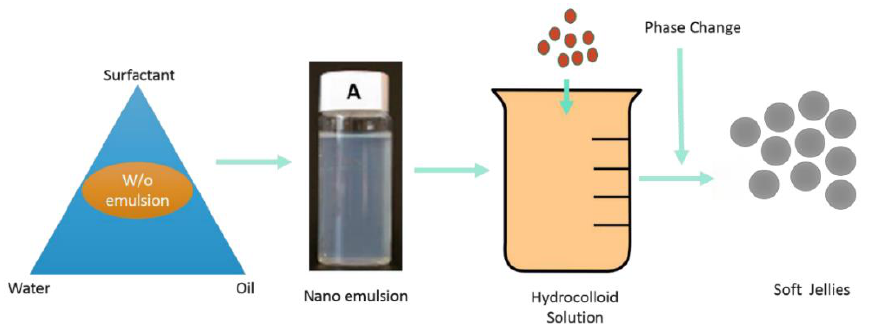
Figure 1. Formulation development process from nano emulsion optimization to gummy formation.